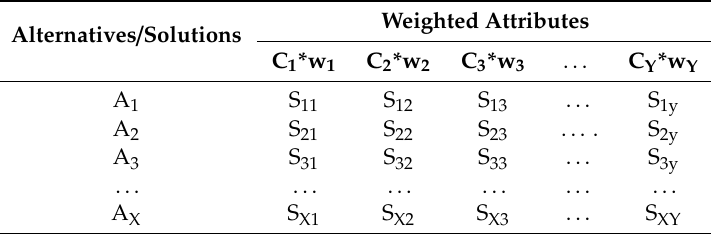
Table 1. Generic decision matrix in multiple attribute decision-making (MCDM) methodologies.